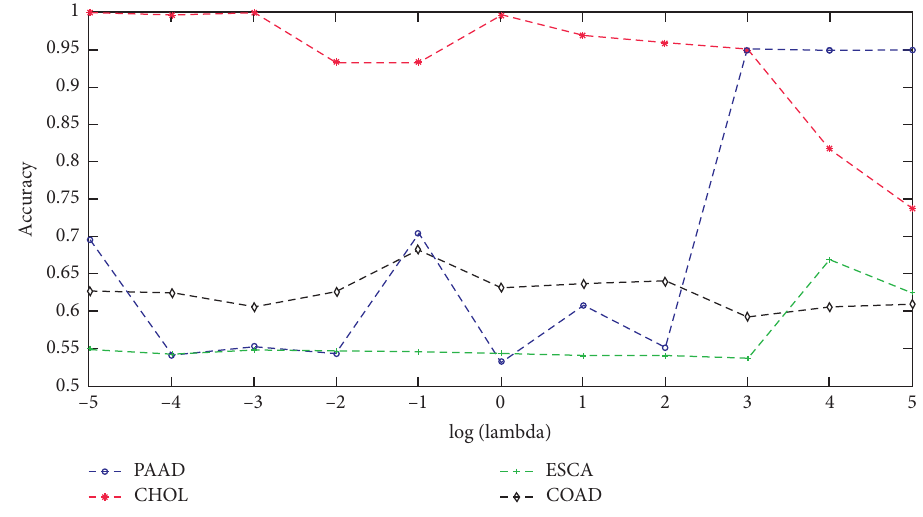
Figure 4: Accuracy of SG-jNMF varies with λ .